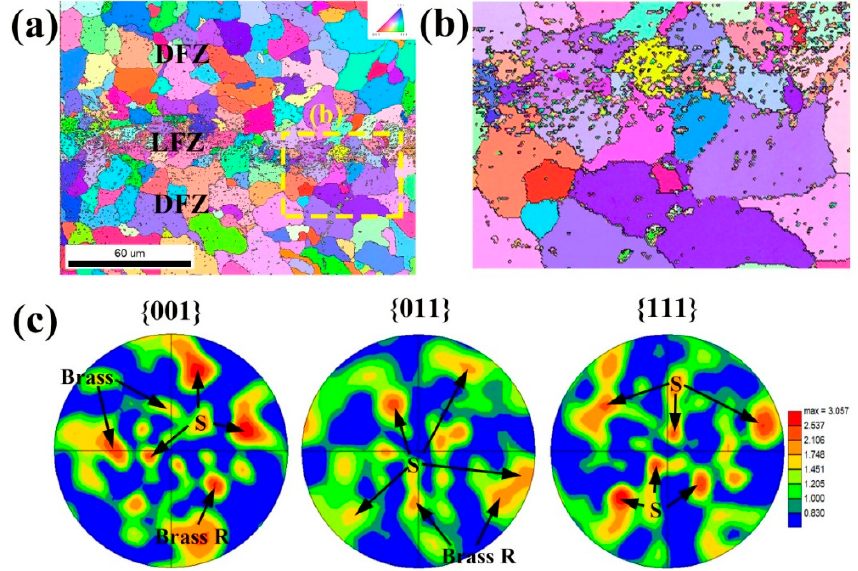
Figure 7. Texture of the flow lines: ( a ) <100> inverse pole figure (IPF); ( b ) the magnified zone in ( a ); ( c ) {001}, {110}, and {111} pole